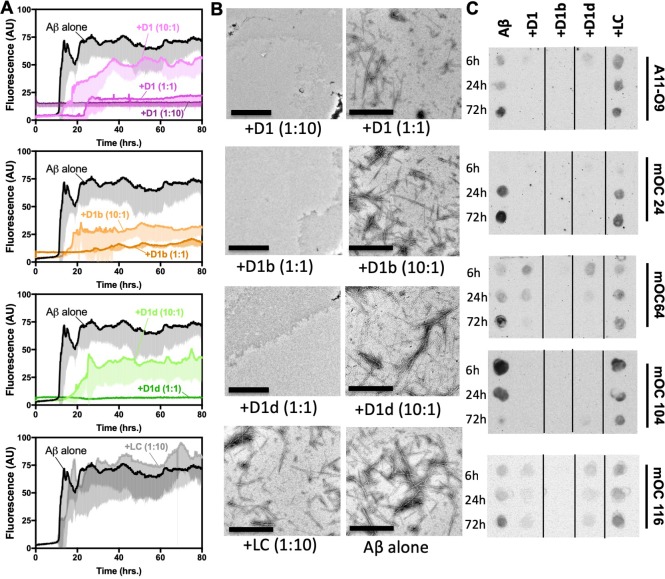
Designed inhibitors reduce aggregation of Aβ1–42.(A) Peptide inhibitors D1, D1b, and D1d reduce fibril formation of Aβ1–42, while negative control peptide LC does not. 10 μM of Aβ1–42 was incubated alone or at a 1:10, 1:1, or 10:1 molar ratio to each inhibitor under quiescent conditions at 37°C. Fibril formation was monitored using ThT fluorescence. Curves show the average of three technical replicates with one standard deviation below. (B) Negative-stain TEM analysis confirms the results of the ThT assays in Figure 3A. Samples were prepared as above and incubated for 72 hr before TEM analysis. Images of Aβ1–42 to D1 (1:10), D1b (1:1) and D1d (1:1) were captured at 3200x; scale bars are 2 µm. All other images were captured at 24,000x; scale bars are 500 nm. (C) Peptide inhibitors reduce the formation of Aβ1–42 assemblies recognized by conformational monoclonal antibodies, while negative control peptides do not. 10 μM Aβ1–42 was incubated alone (left-most column) or with 10-fold molar excess of each peptide-based inhibitor. Aliquots of the reaction were tested for antibody-binding at 6 hr, 24 hr, and 72 hr. Membranes were spliced as indicated for clarity.10.7554/eLife.46924.012Figure 3—source data 1.Dot blot quatification data points.